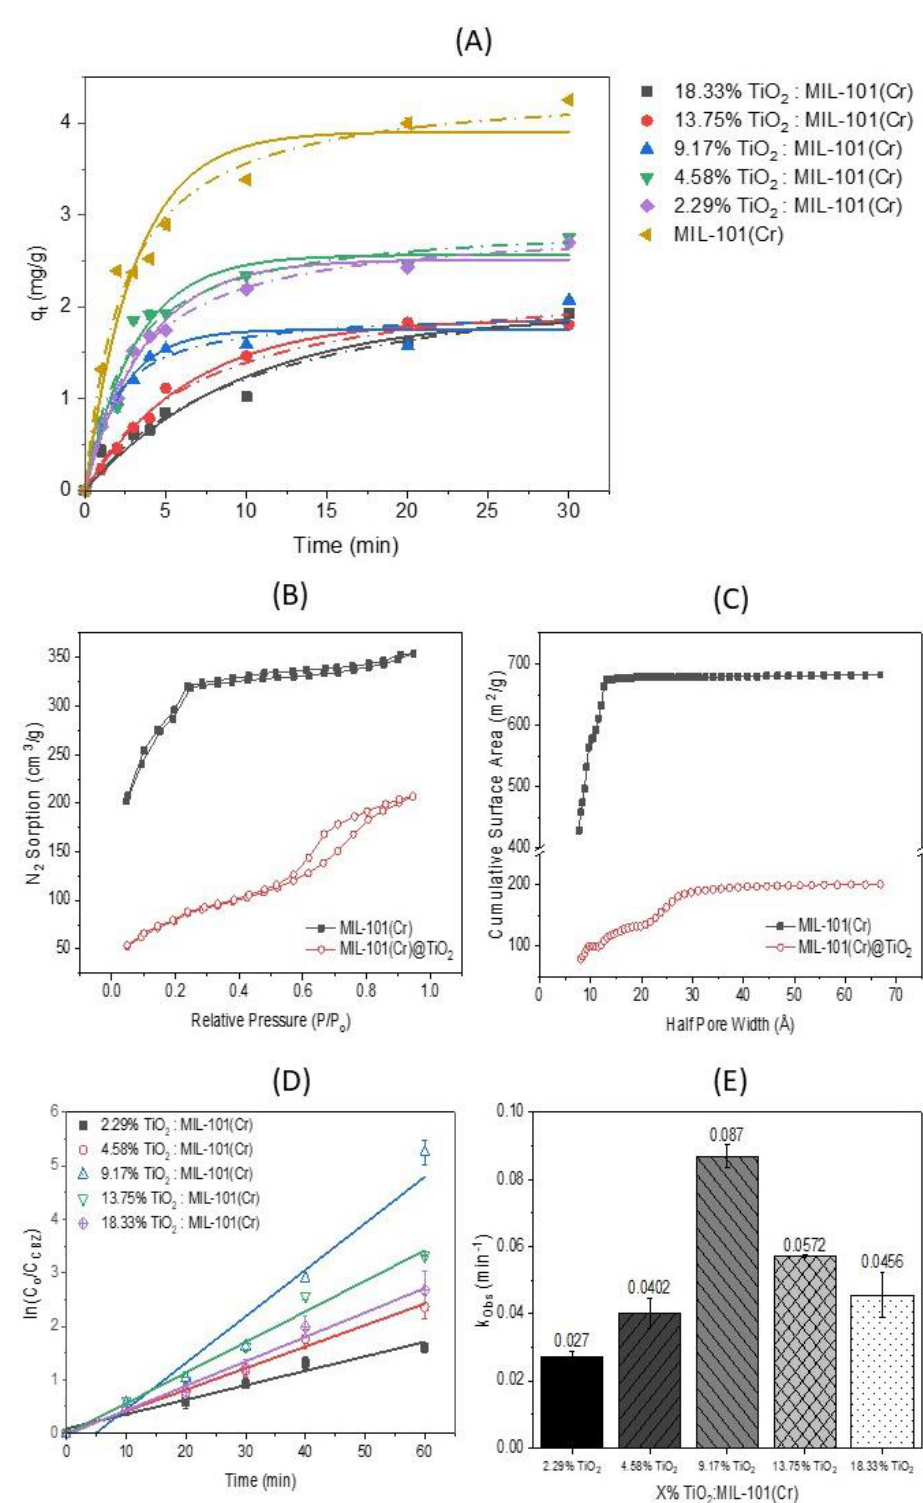
Figure 3. ( A ) Adsorption kinetics models (Pseudo 1st and 2nd) for varied percentages of TiO 2 : MIL-101(Cr) composite; ( B ) N 2 adsorption–desorption isotherms; ( C ) BET cumulative specific surface area of MIL-101(Cr) and 9.17% MIL-101(Cr)@TiO 2 composite; ( D ) ln(C o /C CBZ ) against time; and ( E ) k Obs , min − 1 for varied MIL-101(Cr): TiO 2 ratio